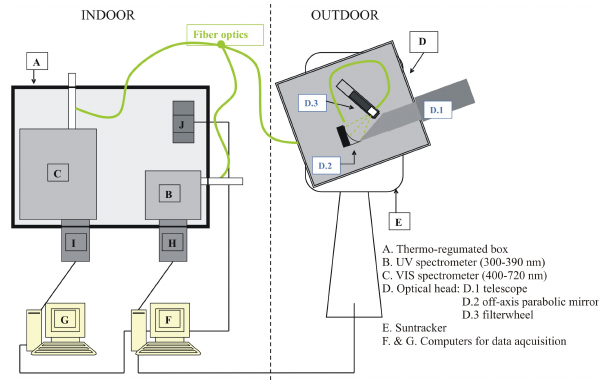
Fig. 1. Schematic view of the MAXDOAS